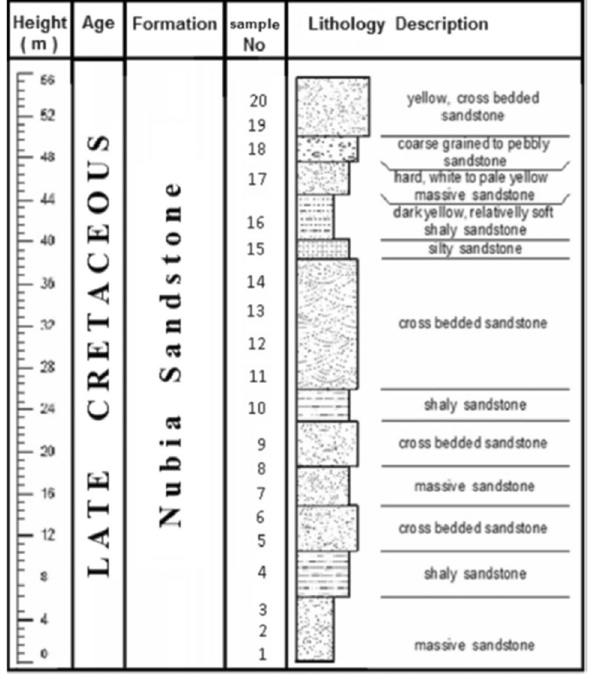
Fig. 2 Generalized stratigraphic column for the Nubian Sandstone sequence in Wadi Kareem, central Eastern Desert, Egypt (modified after Abu Hashish